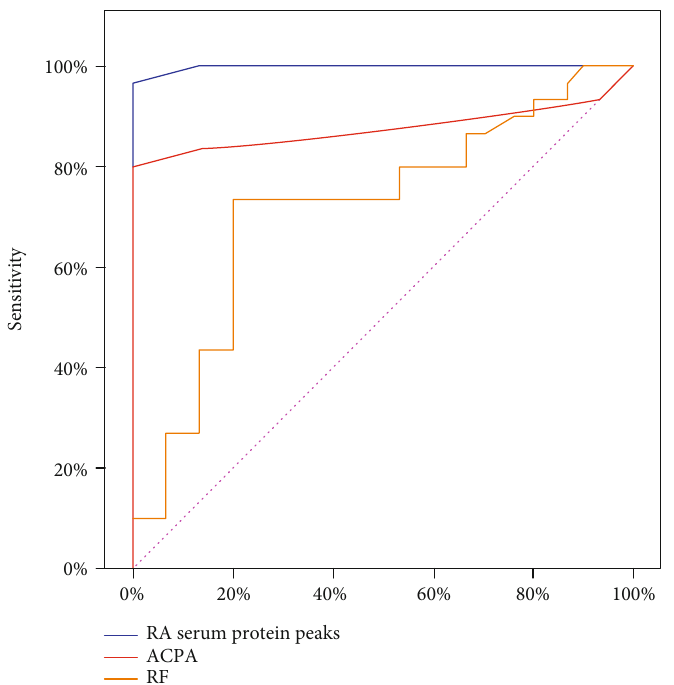
Figure 4: Receiver-operating characteristic (ROC) analysis of the training set samples comparing the diagnostic performance of rheumatoid arthritis (RA) serum protein peaks ( AUC = 0 : 988 ), anti-cyclic citrullinated peptide antibodies (ACPA) ( AUC = 0 : 875 ), and rheumatoid factor (RF) ( AUC = 0 : 720 ) in diagnosing